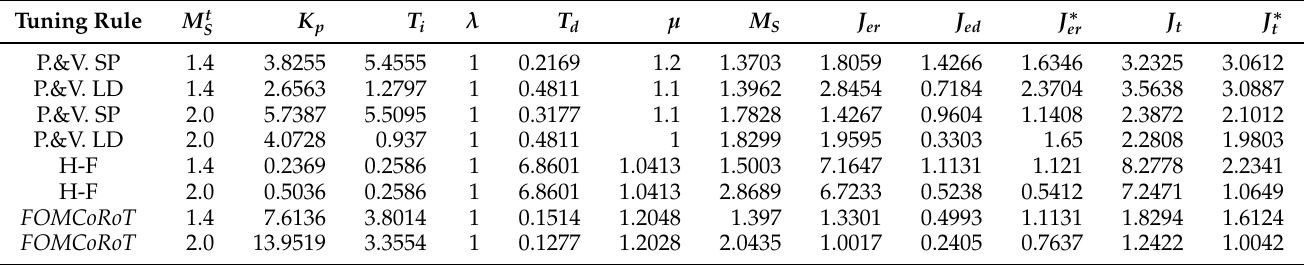
Table 6. Comparison between tuning rules for FOPID controllers in the control of a fractional